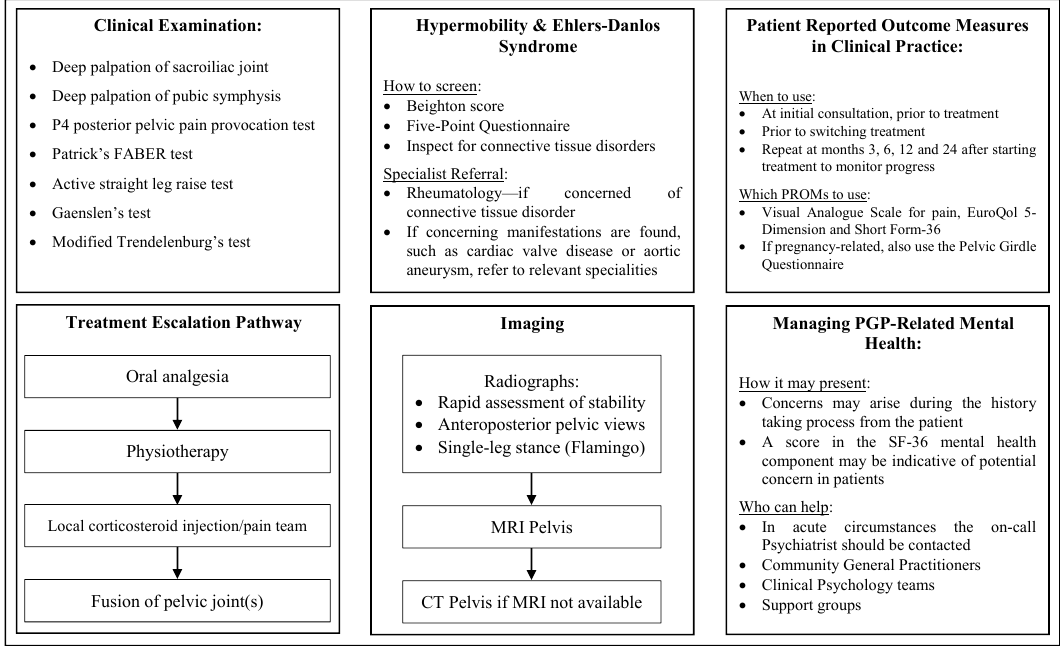
Figure 7. Summarised recommendations for the diagnosis and management of pelvic girdle pain (PGP) and hypermobility.